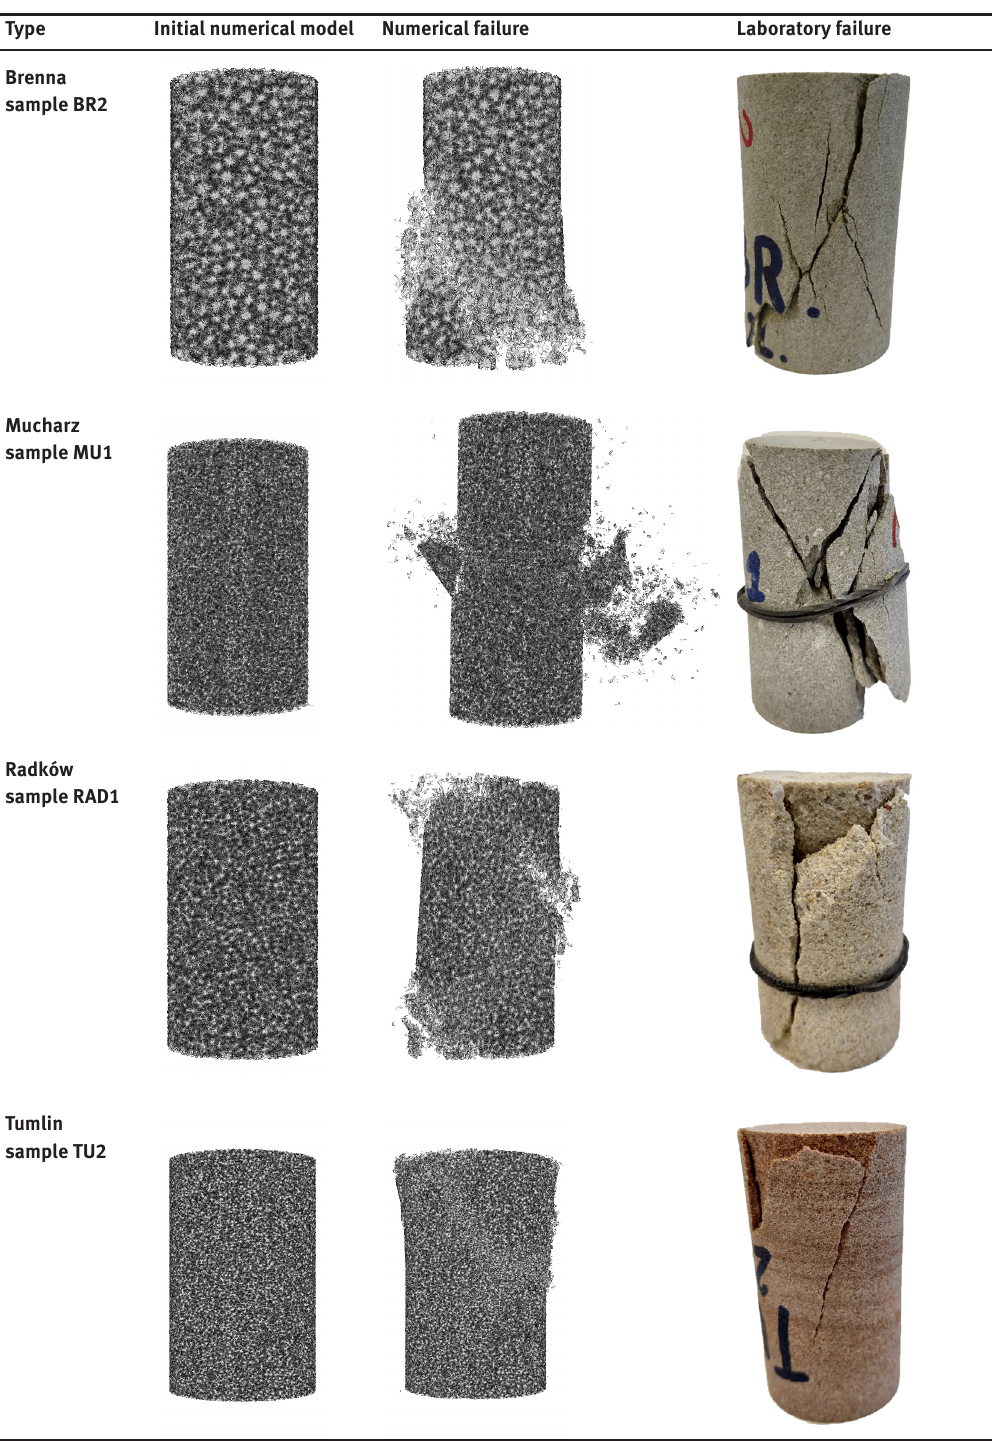
Table 3: Comparison of failure patterns in DEM modeling (initial model, and model just after the failure - view of bonds between particles) and in laboratory (laboratory